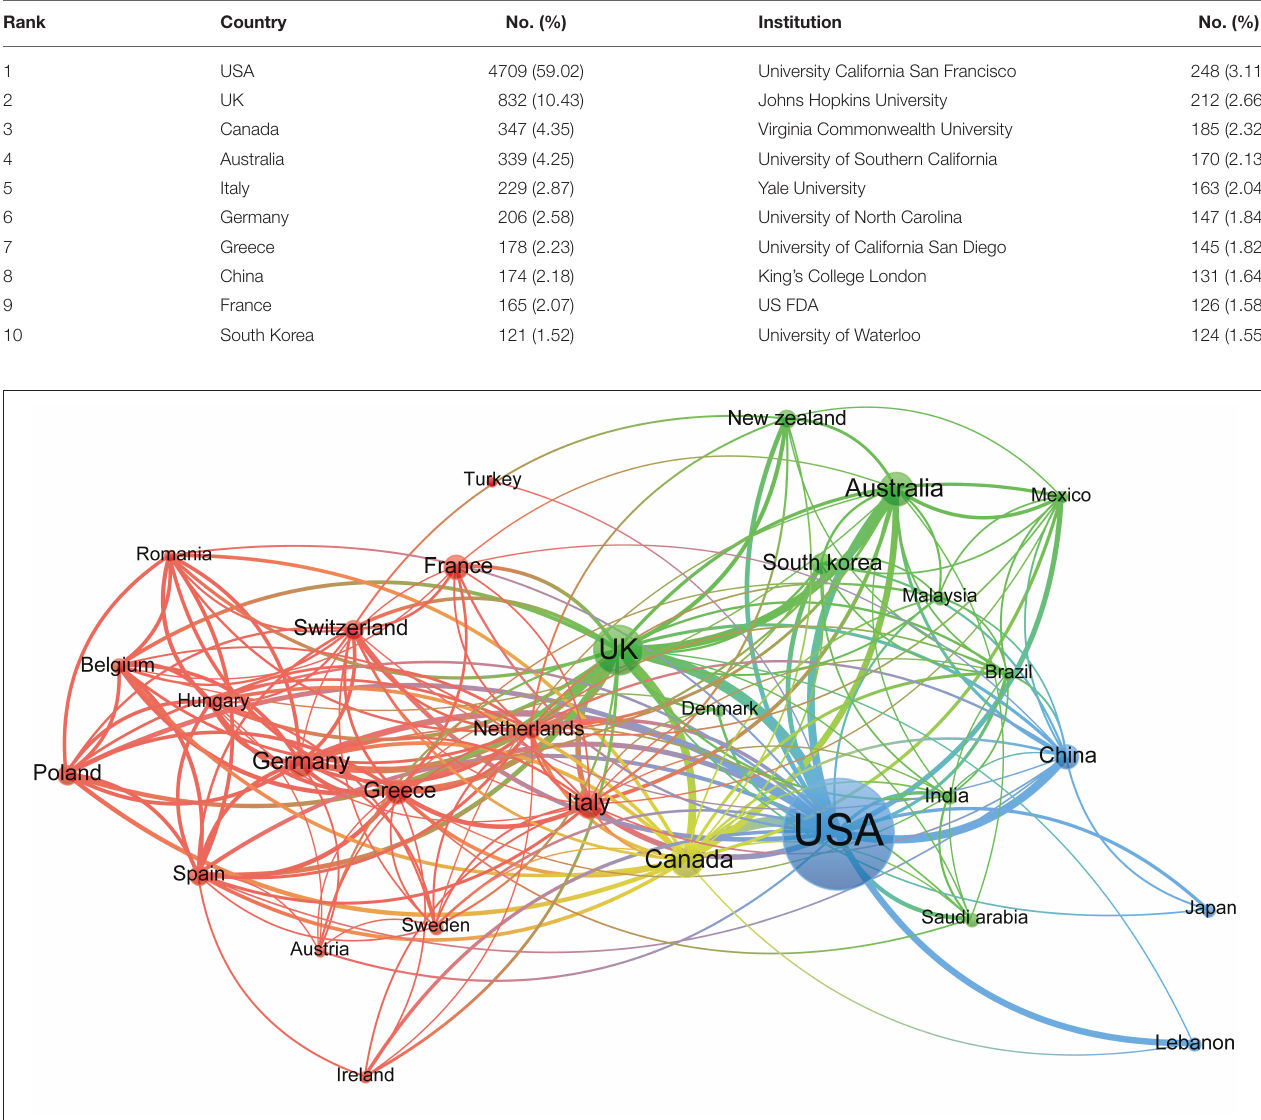
FIGURE 2 | The network map of countries for e-cigarettes